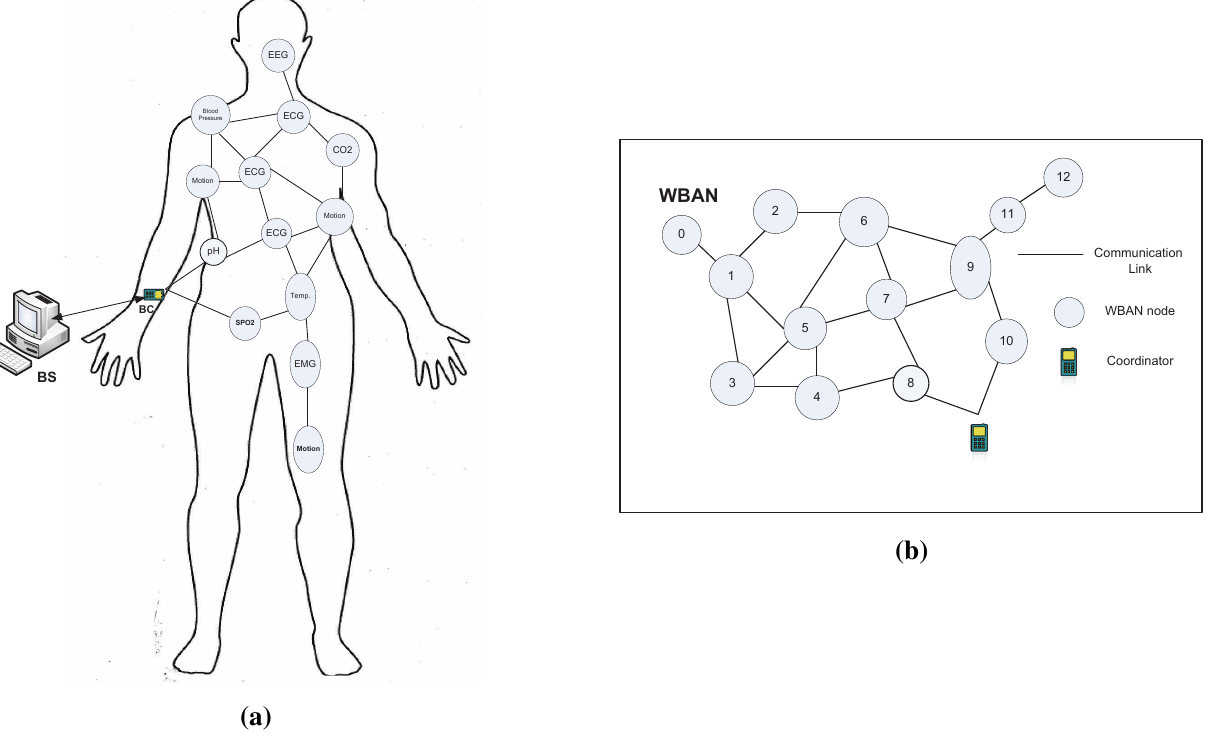
Figure 1. Network Model. ( a ) A Wireless Body Area Network (WBAN); ( b ) Communication Network